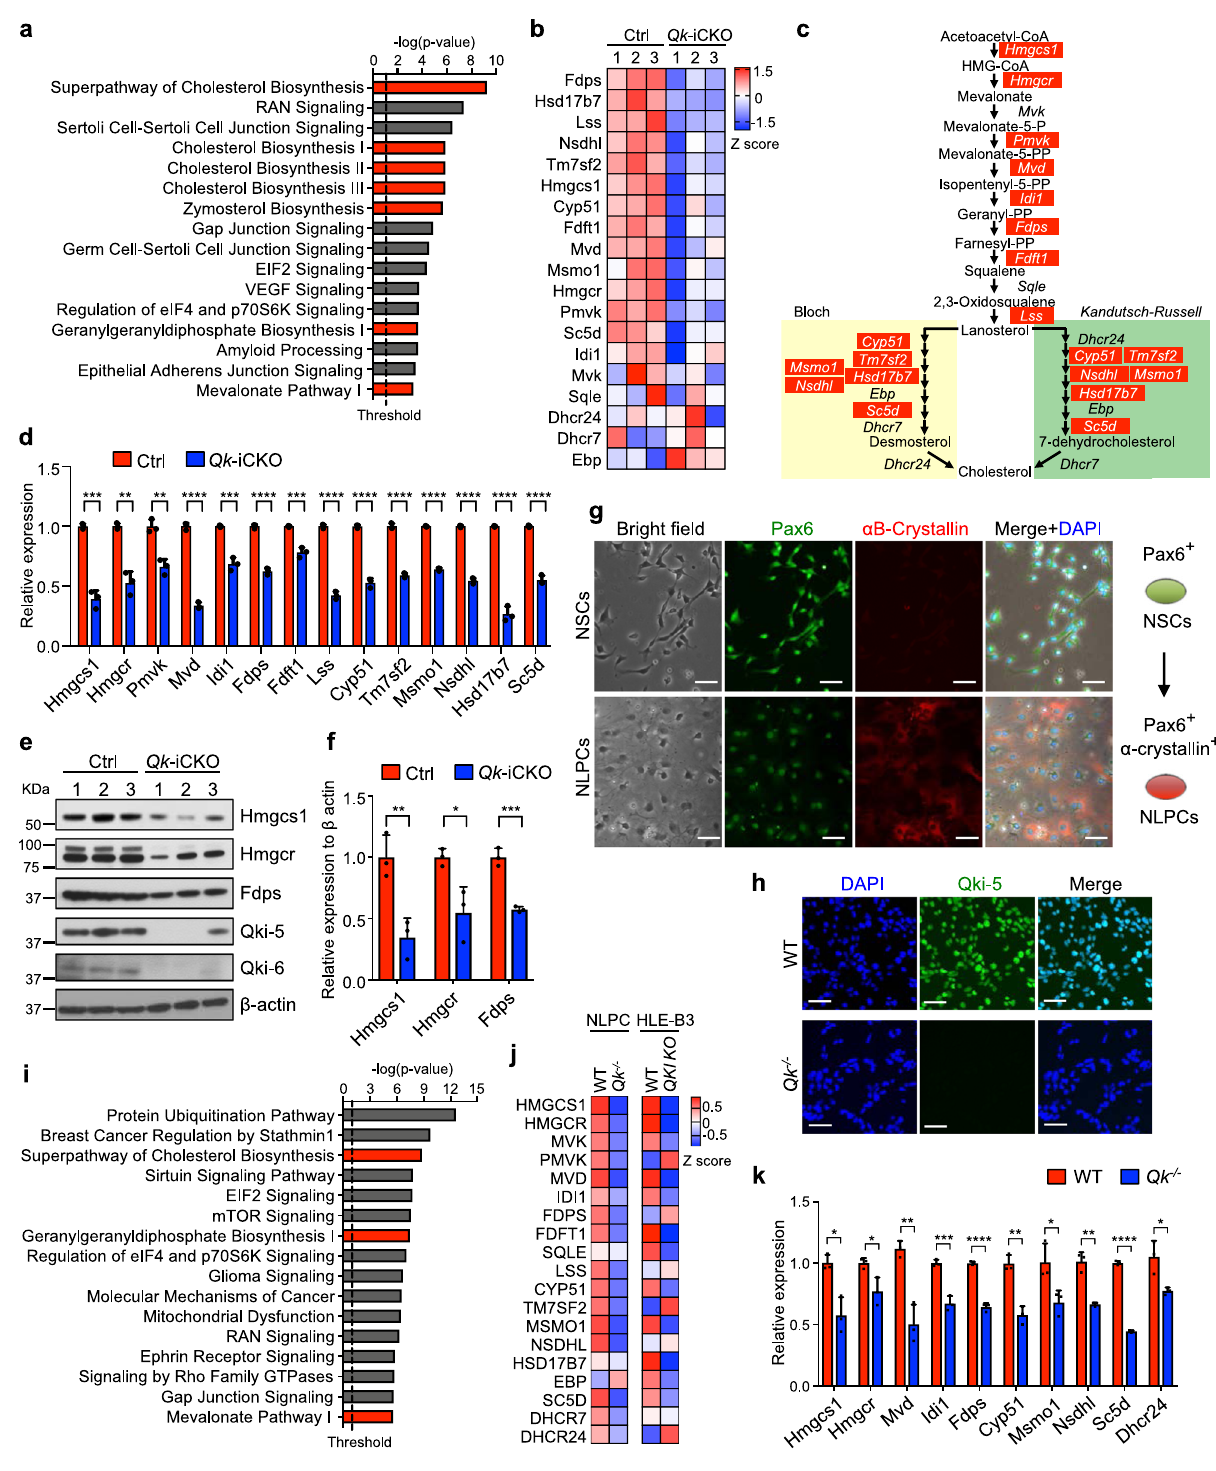
(WT), which was in line with the RNA-seq data in HLE-B3 cells (Fig. 2j). Consistently, RT-qPCR validated the reduced mRNA expression of cholesterol biosynthesis genes enriched in RNA-seq in NLPCs (Fig. 2k). We next asked whether downregulation of cholesterol biosynthesis genes induced by Qk de fi ciency results in a decreased cholesterol level. We found that the cellular cholesterol level as visualized using fi lipin staining was reduced upon Qk deletion from lens cells at P19 (Fig. 3a, b). Consistently, the total free